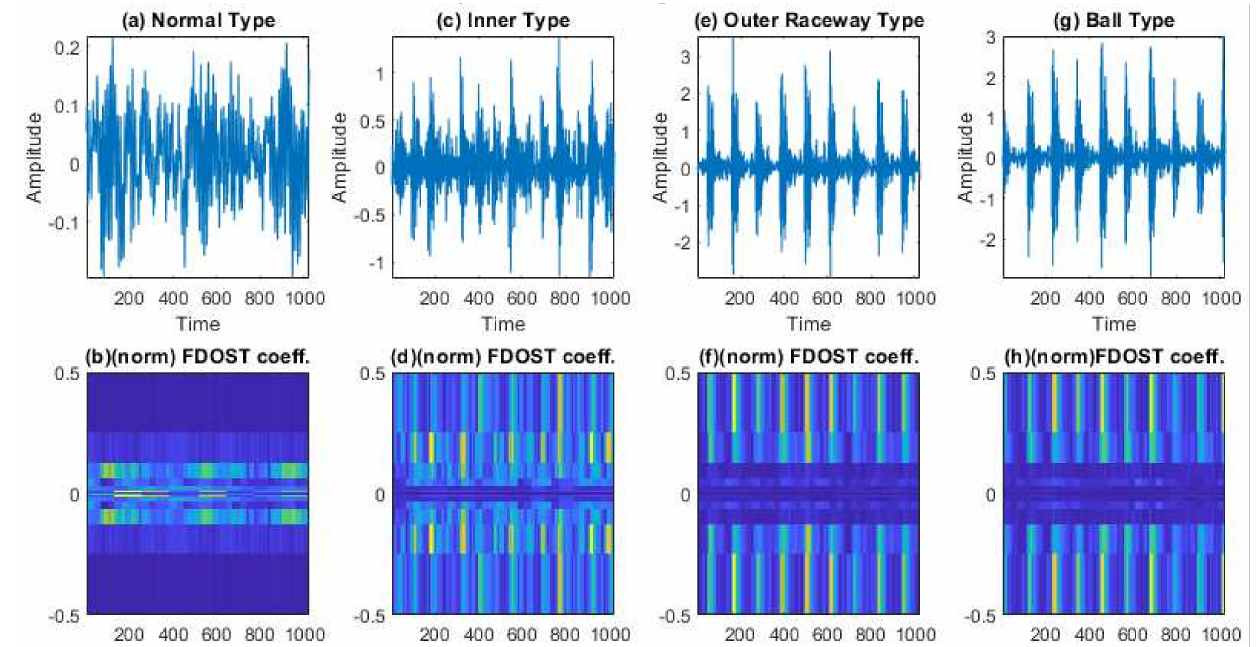
Figure 8. The visualization of dataset 1 in terms of raw time domain signals and respective 2D FDOST coefficient matrix— ( a , b ): time domain, and 2D FDOST coefficient of NT, ( c , d ): time domain, and 2D FDOST coefficient of IRT, ( e , f ): time domain, and 2D FDOST coefficient of ORT, and ( g , h ): time domain, and 2D FDOST coefficient of BT.